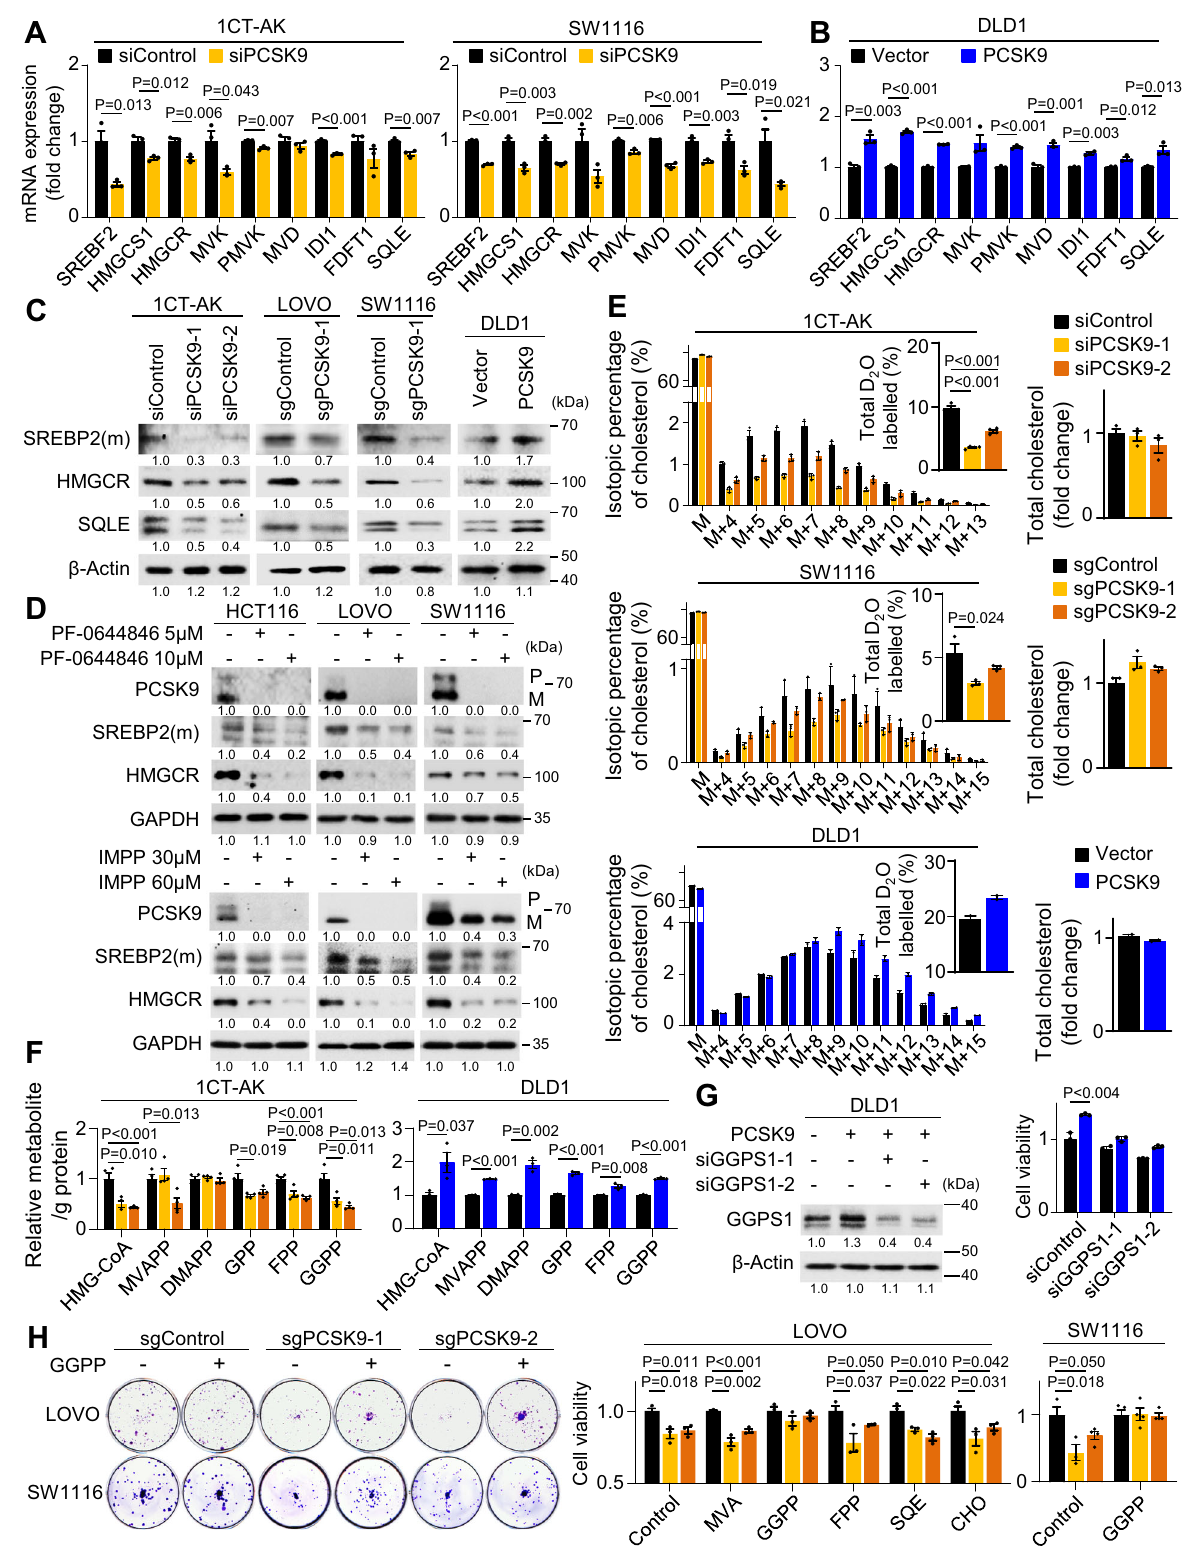
PCSK9 inhibitors synergize with HMGCR inhibitors to sup- press APC / KRAS -mutant CRC . HMGCR inhibitors suppress cancer cell growth; however, drug resistance arises from choles- terol depletion and subsequent up-regulation of SREBP2 and HMGCR. As PCSK9 inhibition reduced SREBP2 and